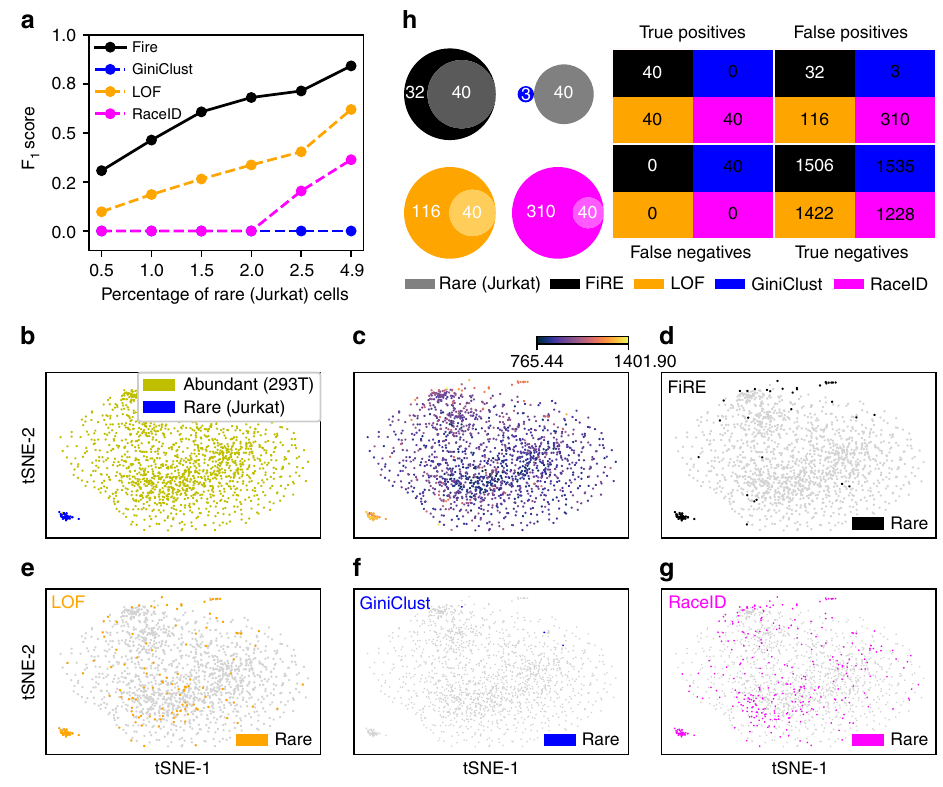
Fig. 3 Detectability of minor cell types in a simulated dataset consisting of Jurkat and 293T cells. a F 1 scores were calculated w.r.t. the rare (Jurkat) population, while bioinformatically varying the proportion of arti fi cially planted rare cells. Notably, both FiRE and LOF 21 apply a threshold to their continuous scores for zeroing on the rare cells. On the contrary, GiniClust 16 and RaceID 15 provide binary annotations for cell rarity. b The t-SNE-based 2D embedding of the cells with color-coded identities. c FiRE score intensities plotted on the t-SNE-based 2D map. d – g The rare cells detected by various algorithms are highlighted. h Congruence of methods with known annotations. Note that the results shown in ( b – h ) correspond to a rare cell concentration of